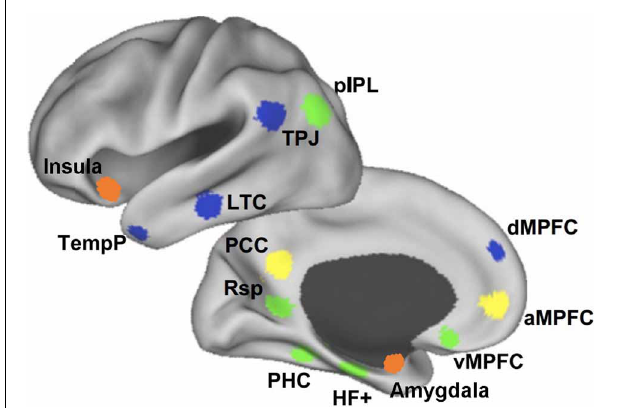
FIGURE 1 | The medial prefrontal cortex (MPFC) plays a key role in the social understanding of others. The subregions of MPFC belong to different subsystems of DMN. At the bottom, the ventral MPFC is in the medial temporal lobe subsystem (green) and its connections with emotion regions are mainly associated with emotion engagement during social interactions. Above, the anterior MPFC is in the cortical midline structures (yellow) and its connections with posterior and anterior cingulate cortex contribute mostly to making self-other distinctions. At the top, the dorsal MPFC (dMPFC) is in the dMPFC subsystem (blue) and its connection with the temporo-parietal junction (TPJ) are primarily related to understanding others’ mental states (Andrews-Hanna et al., 2010b). The orange clusters show the anterior insula and amygdala, which contribute greatly in the social understanding of